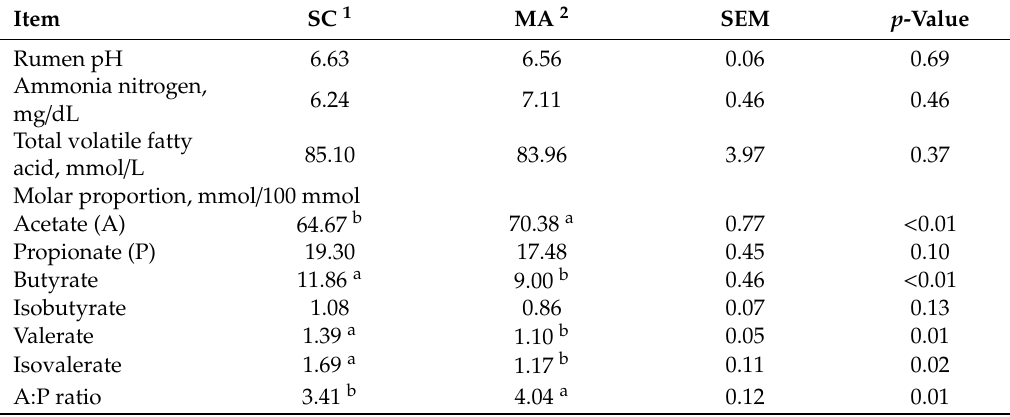
Table 2. Observed rumen fermentation parameters of dairy cows from SC and MA